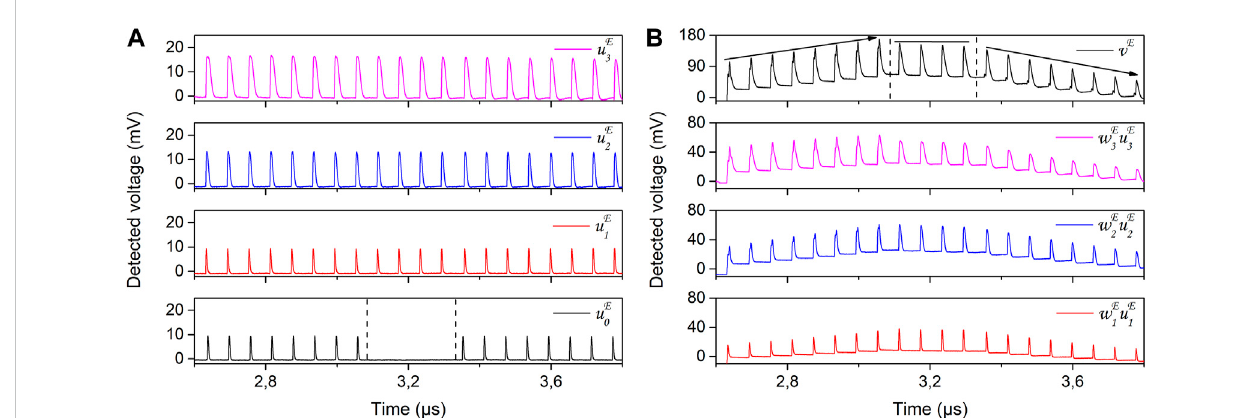
FIGURE 8 ICO rule applied to the experimental ODU in an open loop con fi guration. (A) Measured fi ltered input signals ( u E i ) that propagate along the four DBs before weighting, in absence of weighting and the rest of the inputs. The dashed lines separate the three different reference fi ltered input signal conditions. (B) Weighted fi lteredinputsignalsinthethreeplasticDBs ( w E i u E i ) andODUoutputsignal( v E ).Theweights w E i areobtainedfromtheSOAMODs electro-optic response, after feeding the numerically calculated values w i . The experimentally measured signals are obtained at the ODU output.